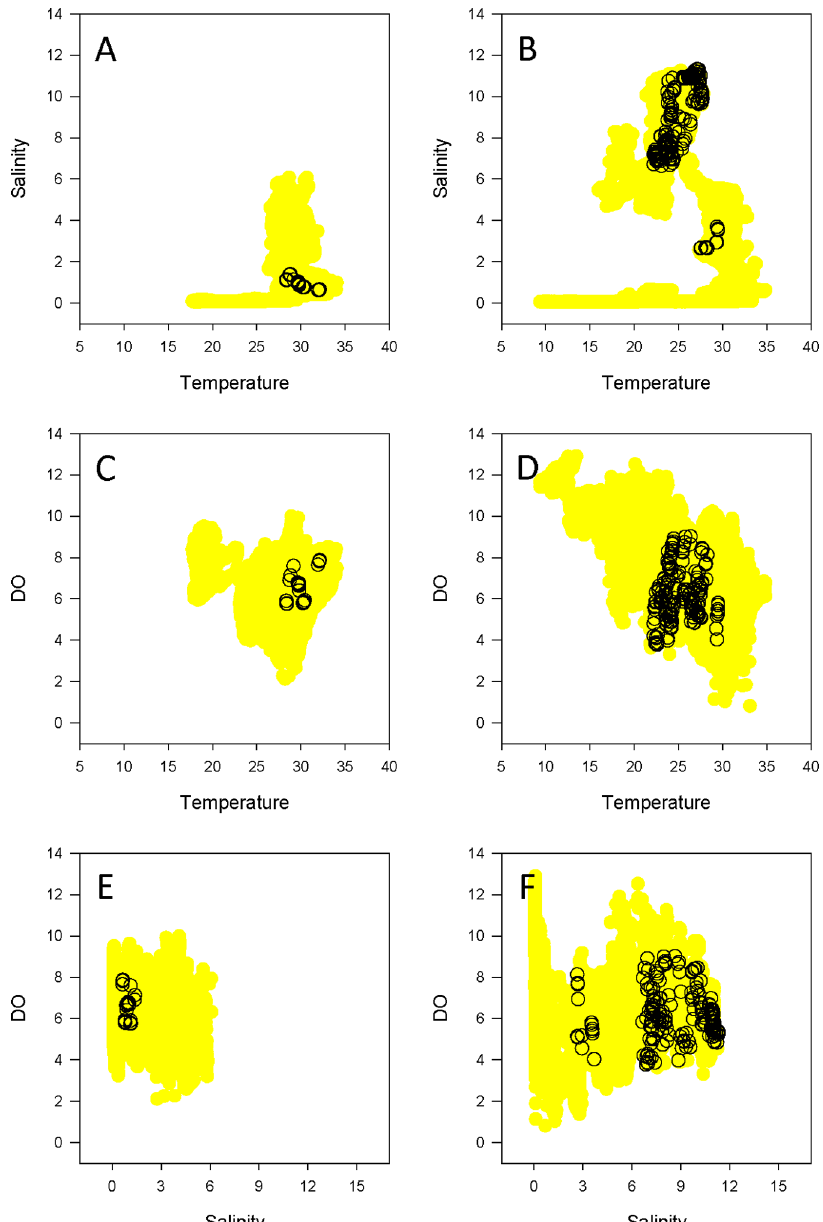
Figure 7. Bull shark dynamic habitat use in the upper bay. Dynamic habitat use of the upper Mobile Bay by bull sharks acoustically detected in 2009 (left column) and 2010 (right column): Temperature vs. Salinity (A, B), Temperature vs. Dissolved Oxygen (C, D), and Salinity vs. Dissolved Oxygen (E, F) are shown. Areas in yellow indicate the available dynamic habitat (data from the NEP mooring stations), and open circles indicate the presence of telemetered bull